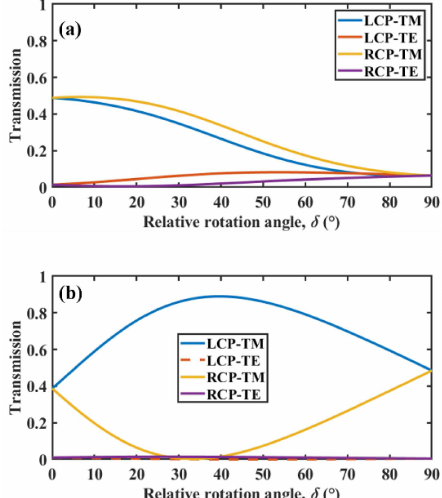
Figure 5. TE wave and TM wave components in the transmitted wave as a function of the rotation angle for LCP and RCP waves: ( a ) f = 0 and ( b ) f =